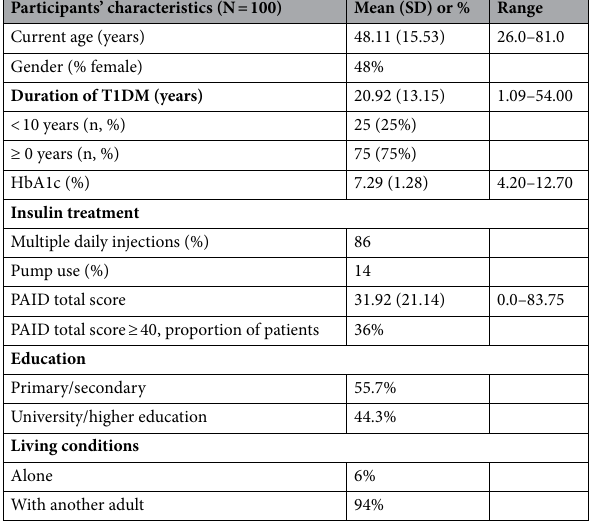
Table 1. Participants’ characteristics.